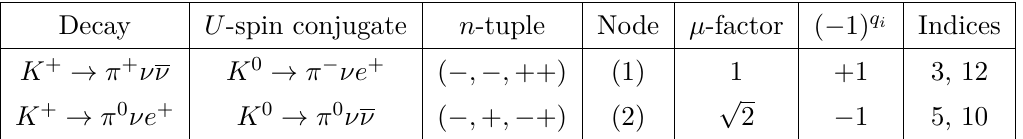
Table 4 . The mapping of the U -spin pairs of semileptonic K → π decays into generalized n -tuples.